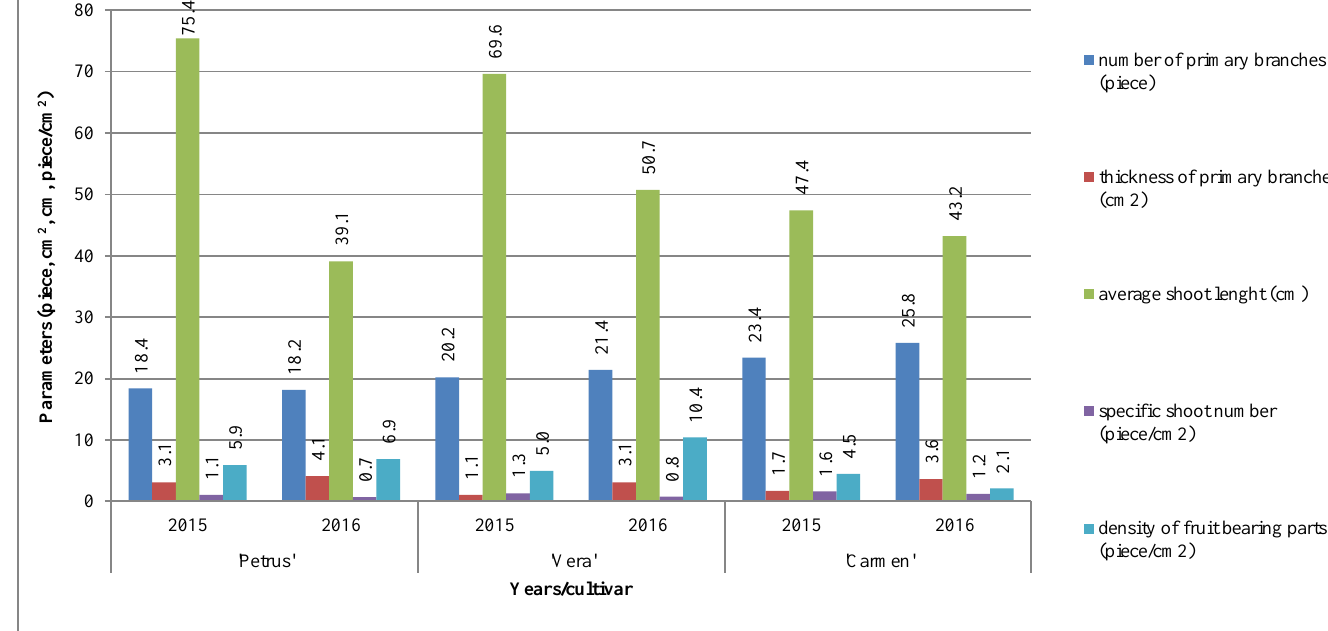
Figure 4. Parameters of shoots, branches and fruit bearing parts on slender spindle canopy (Debrecen – Pallag,